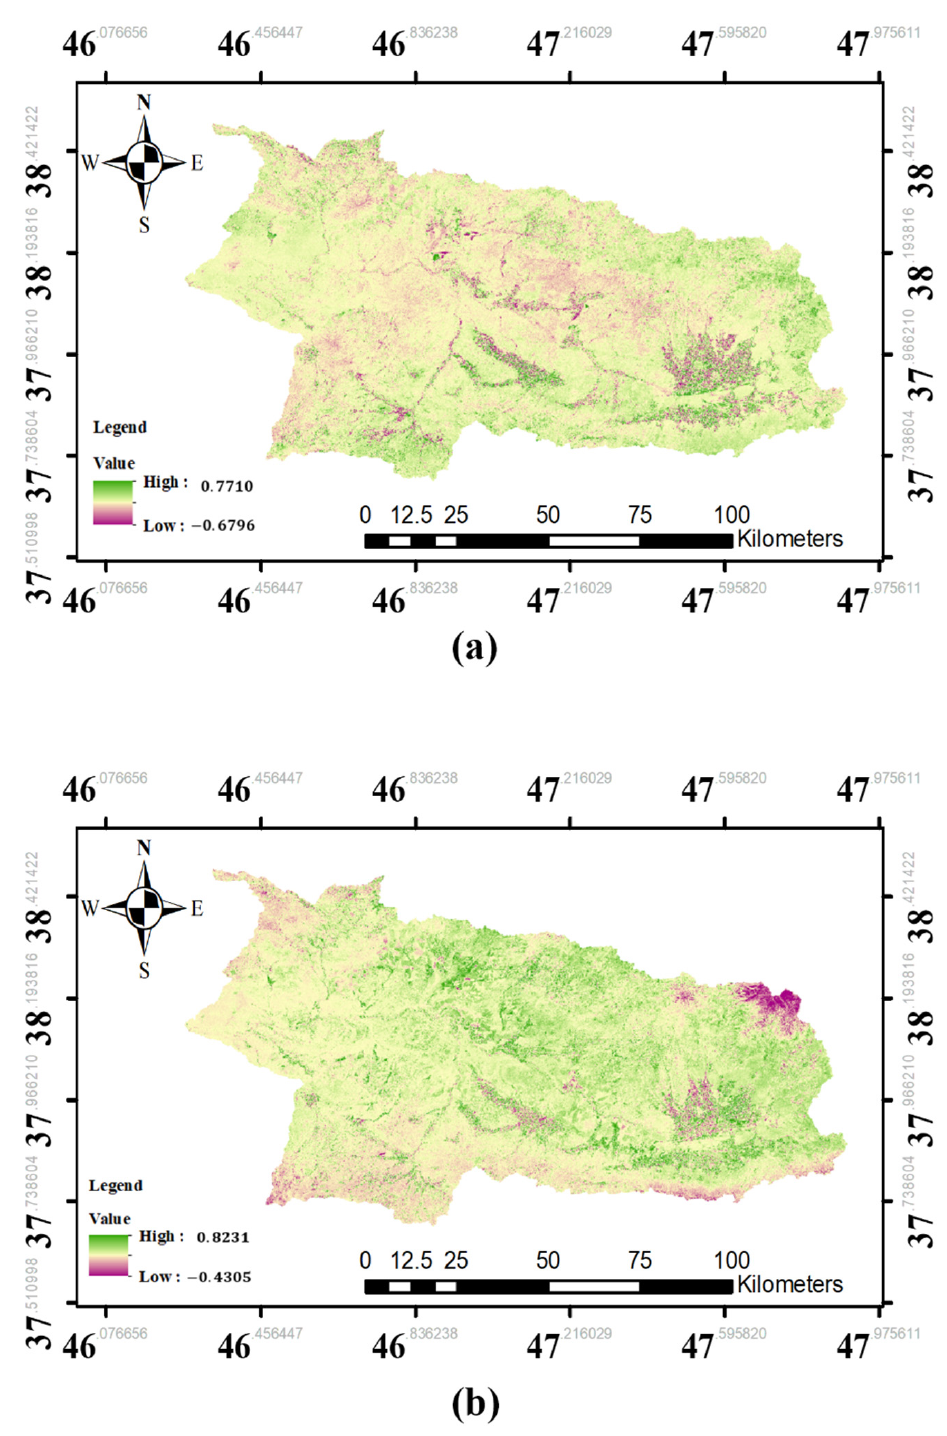
Figure 10. The pixel value change detection maps in the AC watershed between the averaged NDVI